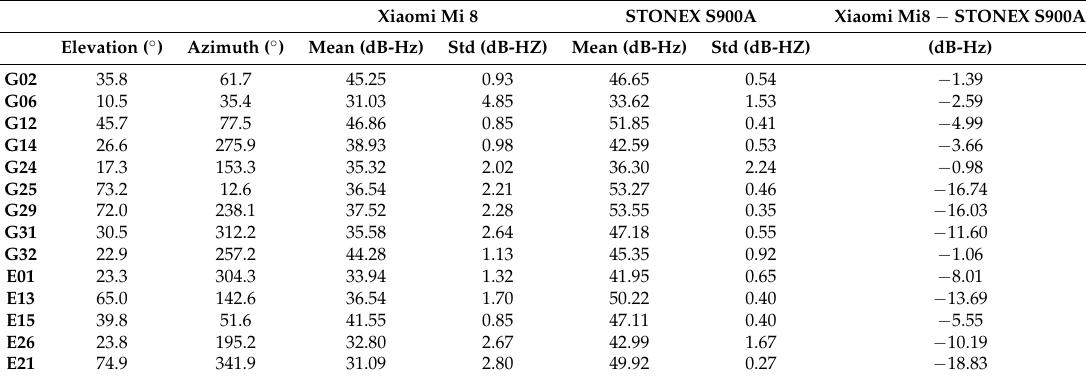
Figure 5. C/No collected from the Xiaomi Mi 8 as a function of the elevation angle for the satellite in view. Table 2. Statistical analysis of C/No from Xiaomi Mi 8 and STONEX